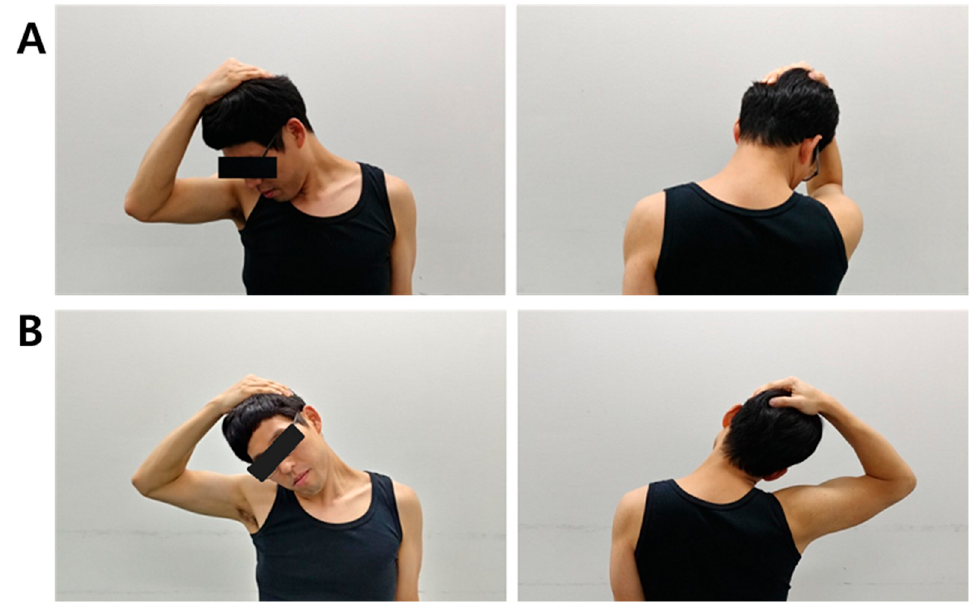
Figure 4. ( A ) Stretching exercise of levator scapular ( B ) upper trapezius.